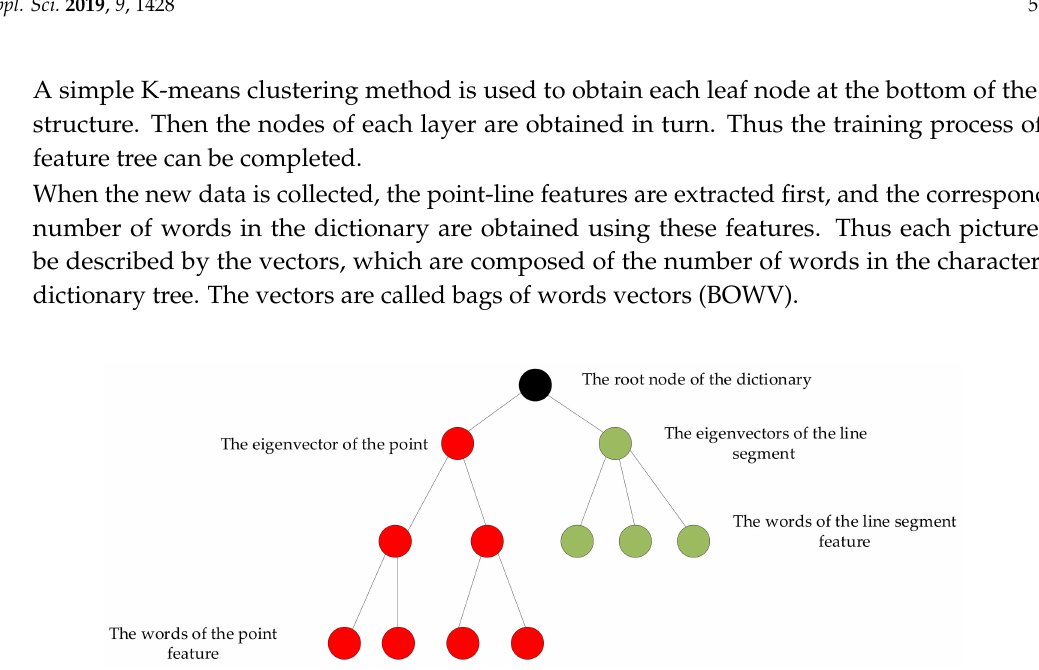
Figure 3. Dictionary tree based on point-line